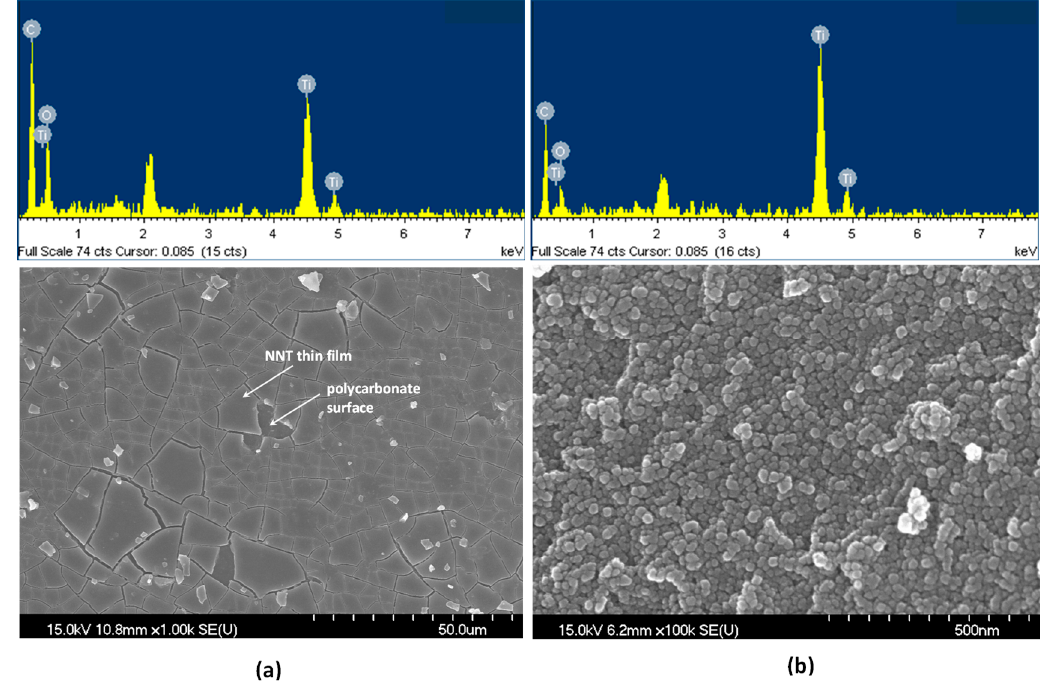
Figure 2. SEM images and EDS of ( a ) NNT-F and ( b ) NNT-P.